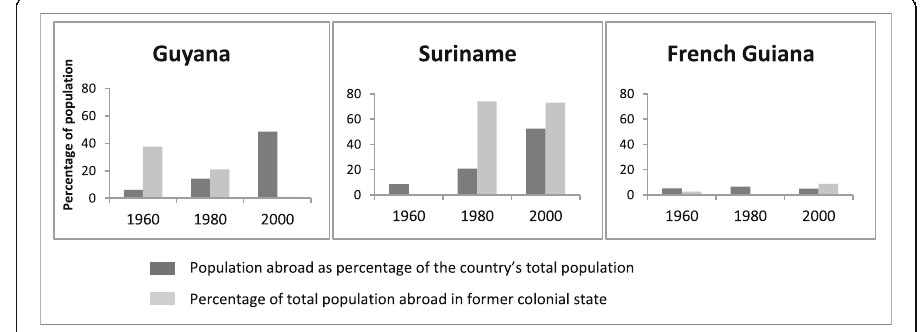
Fig. 2 Percentage of population abroad and in former colonial state, Guyana, Suriname and French Guiana, 1960 – 2000